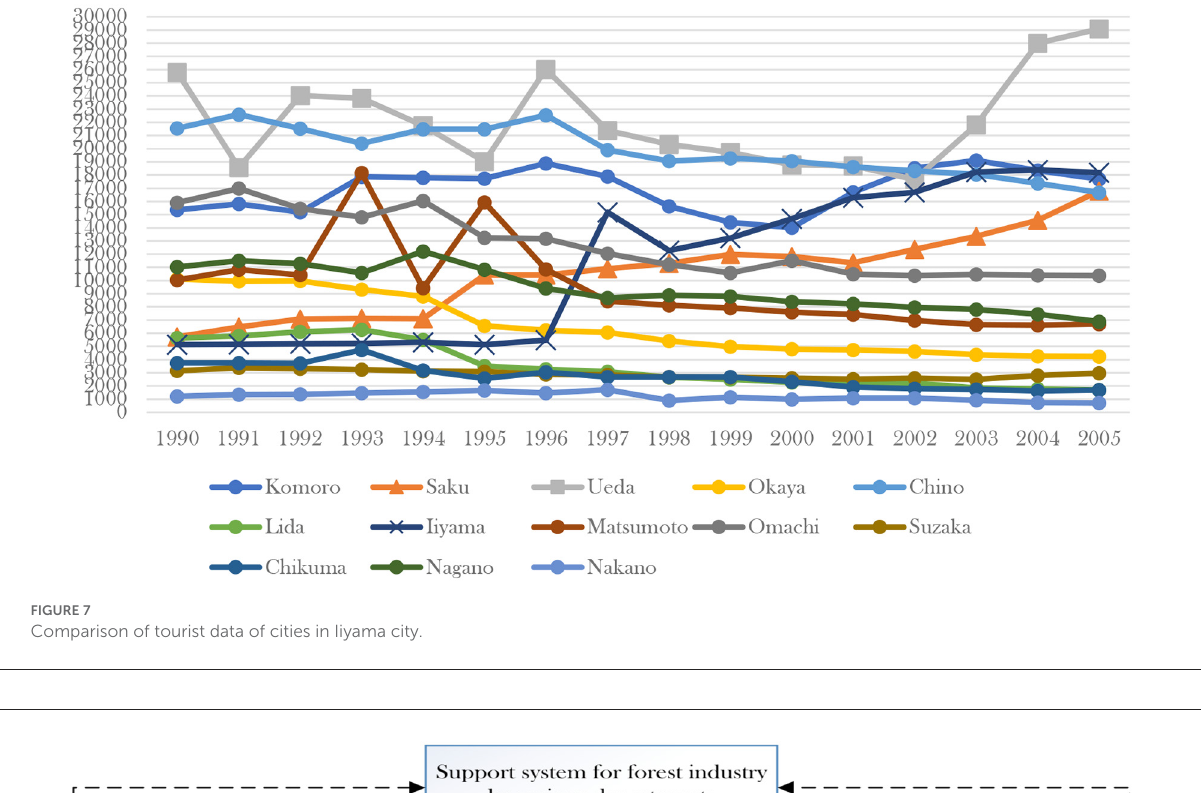
FIGURE7 Comparison of tourist data of cities in Iiyama city.